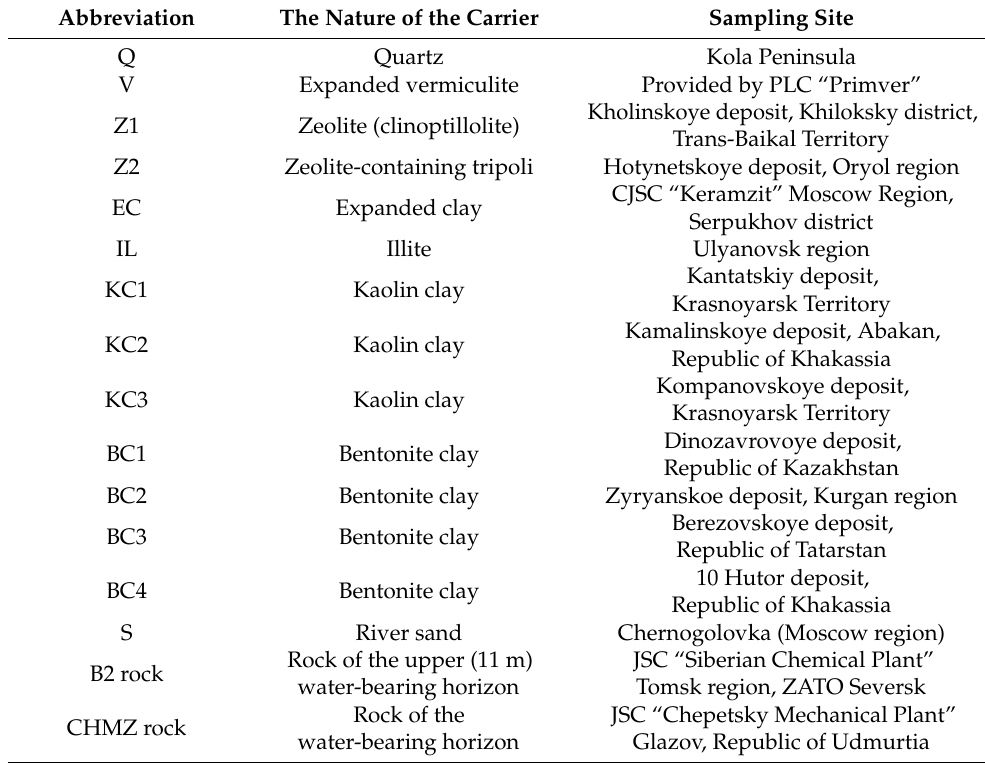
Table 2. Mineral carriers used in this